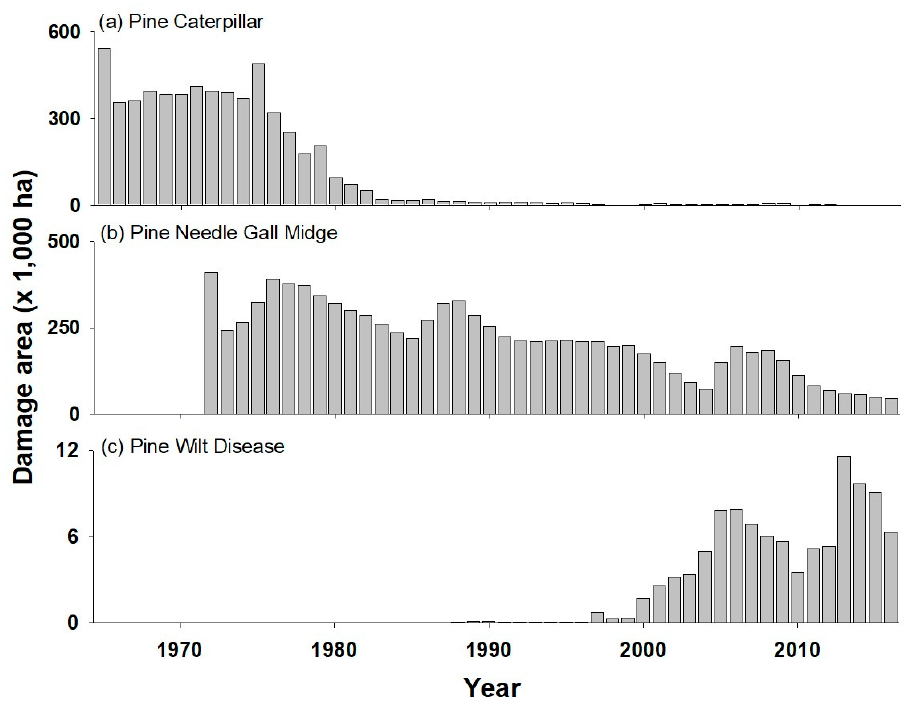
Figure 2. Changes of area damaged by forest pests in Korea. ( a ) Pine caterpillar, ( b ) pine needle gall midge, and ( c ) pine wilt disease. The graphs were redrawn based on data from Statistical Yearbook of Forestry [14] .